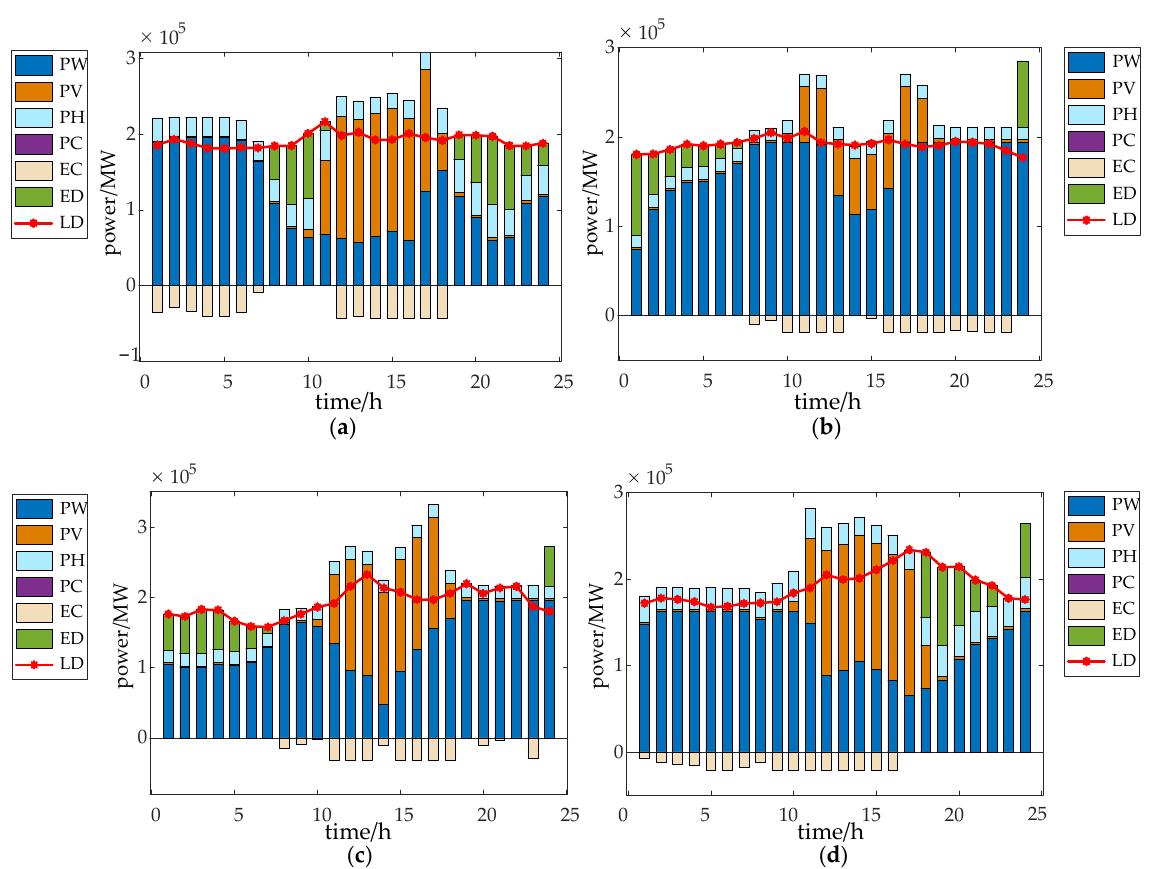
Figure 15. The operational results in 2050. ( a ) typical day 1; ( b ) typical day 2; ( c ) typical day 3; ( d ) typical day 4.